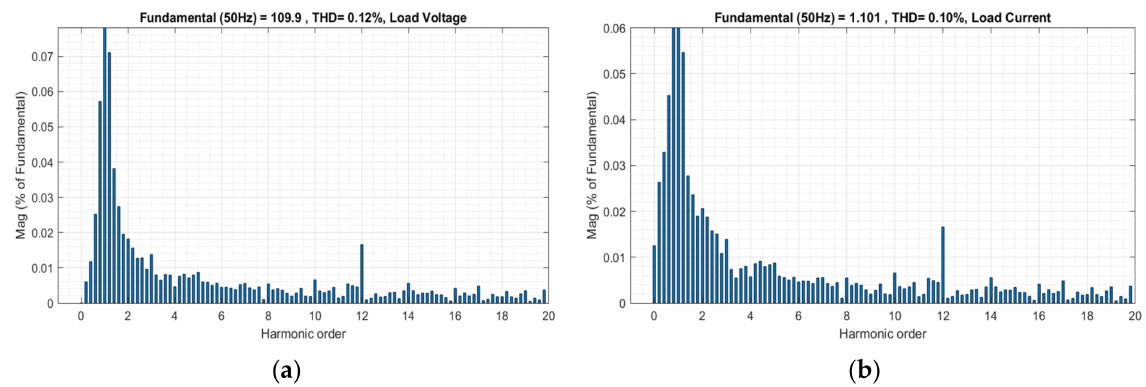
Figure 4. Load Voltage and Current THD Analyzing in Steady State Operation: ( a ) the THD of the Load Voltage, ( b ) the THD of the Current Load.